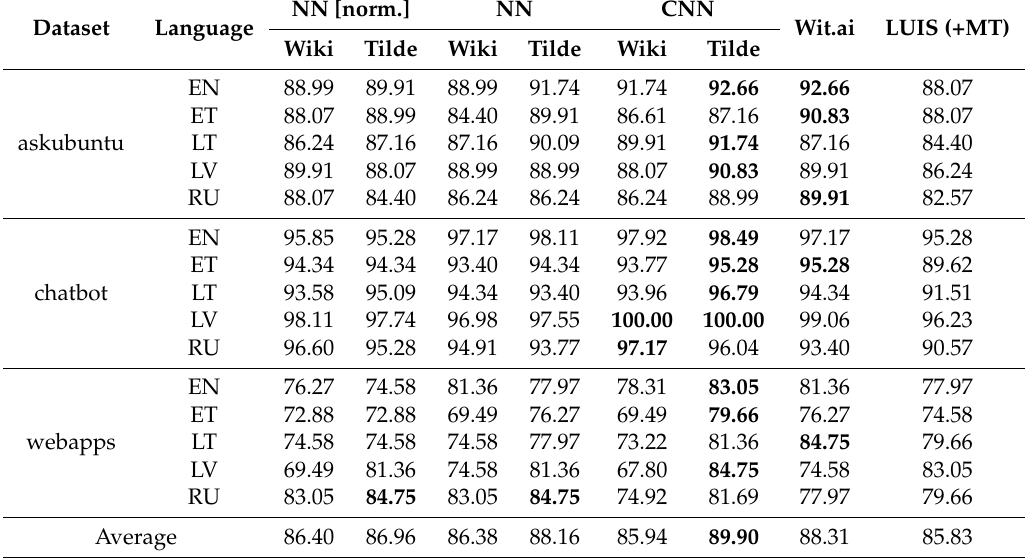
Table 6. Intent detection accuracy (in percentages) of the evaluated methods. NN [norm.] and NN are the feedforward neural networks using normalized and unnormalized versions of the sentence vectors, respectively. CNN is the convolutional network. Wiki and Tilde are the word embeddings trained on Wikipedia by Facebook and the word embeddings trained by us on the large internal corpus, respectively. LUIS (+MT) is the Microsoft LUIS with Microsoft machine translation service